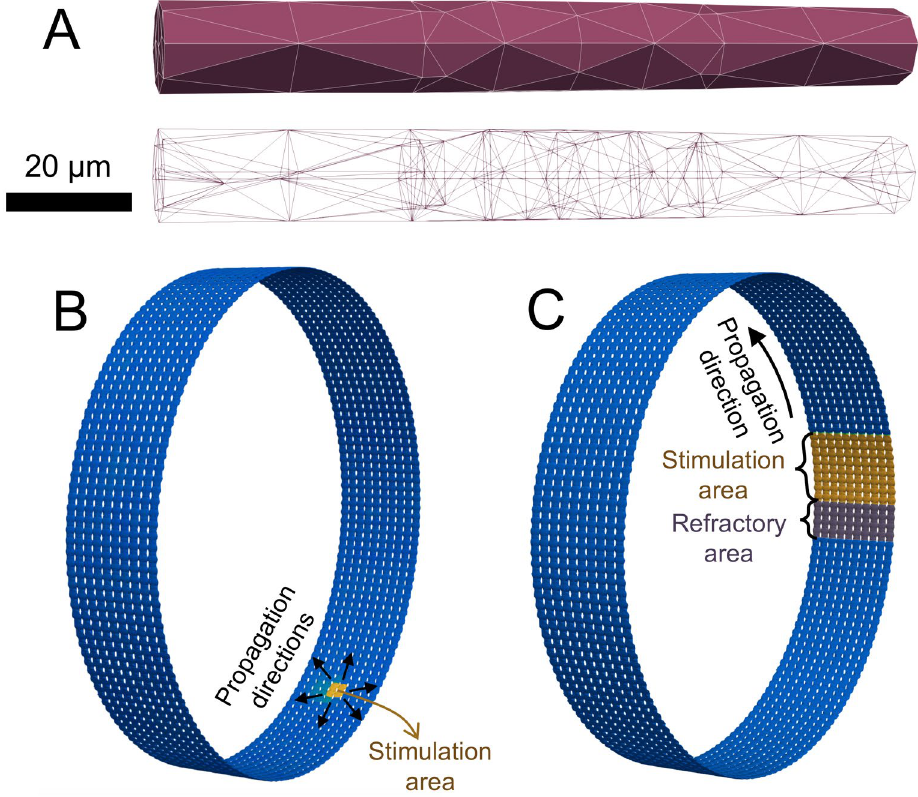
Figure 1. Single myocyte and PV sleeve geometry used in these EMI model simulations. A: The upper illustration shows the surface of a single myocyte within the PV sleeve, and the lower illustration shows the full finite element mesh of the myocyte. In the mesh, each cell is represented by about 85 nodes, of which approximately 80 are located on the membrane or at the intercalated discs. B and C: Illustration of a cylinder of myocytes making up the PV sleeve. Each cell is shaped as illustrated in Panel A. The figure in Panel B also illustrates the stimulation protocol used in the simulations performed to investigate excitability, and the figure in Panel C illustrates the stimulation protocol used to investigate re-entry. Note that to improve the visibility, the cylinders in Panels B and C are not shown to